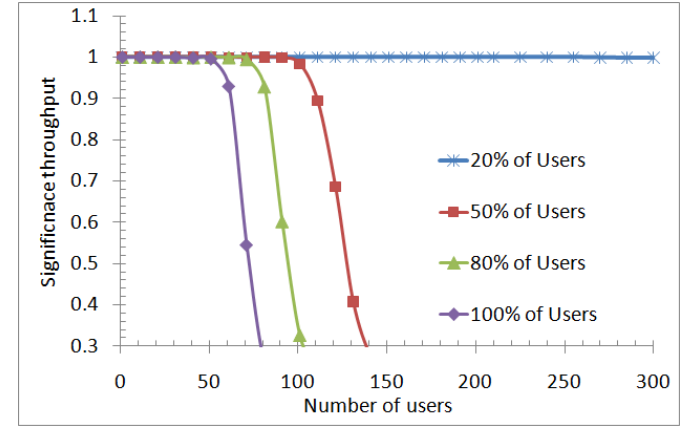
Figure 5. Significance throughput versus number of users for different classes of users and α =